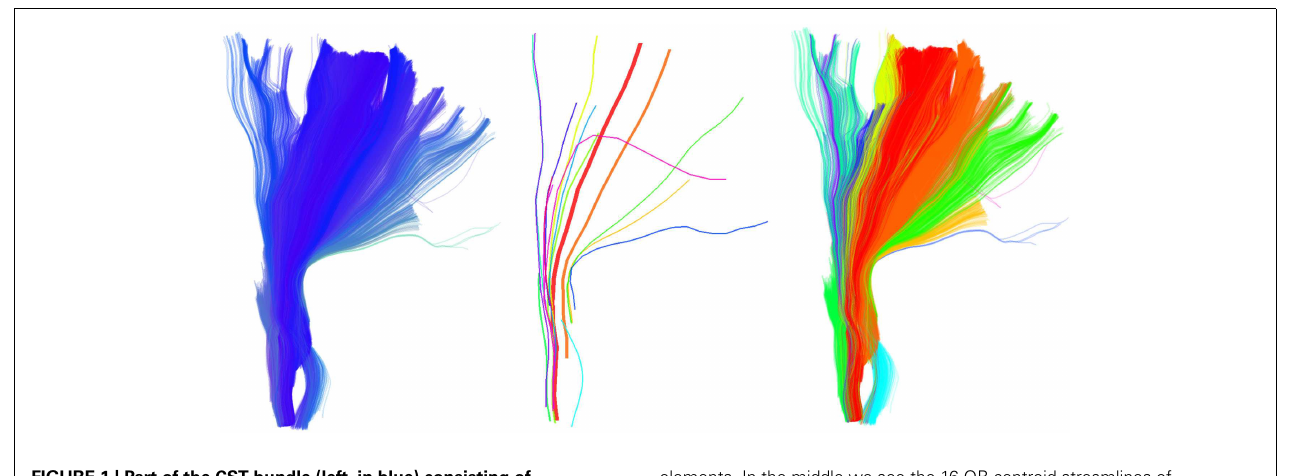
FIGURE 1 | Part of the CST bundle (left, in blue) consisting of 11,041 streamlines. At first glance it looks as though all streamlines have a similar shape, and possibly converge toward the bottom, and fan out toward the top. However, this is a misreading caused by the unavoidable opaque density when all the streamlines are visualized. QB can help us see the finer structure of the bundle and identify its